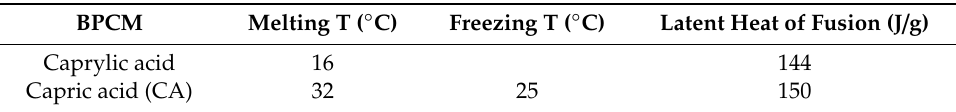
Table 1. Properties of two pure fatty acids suitable for the building application